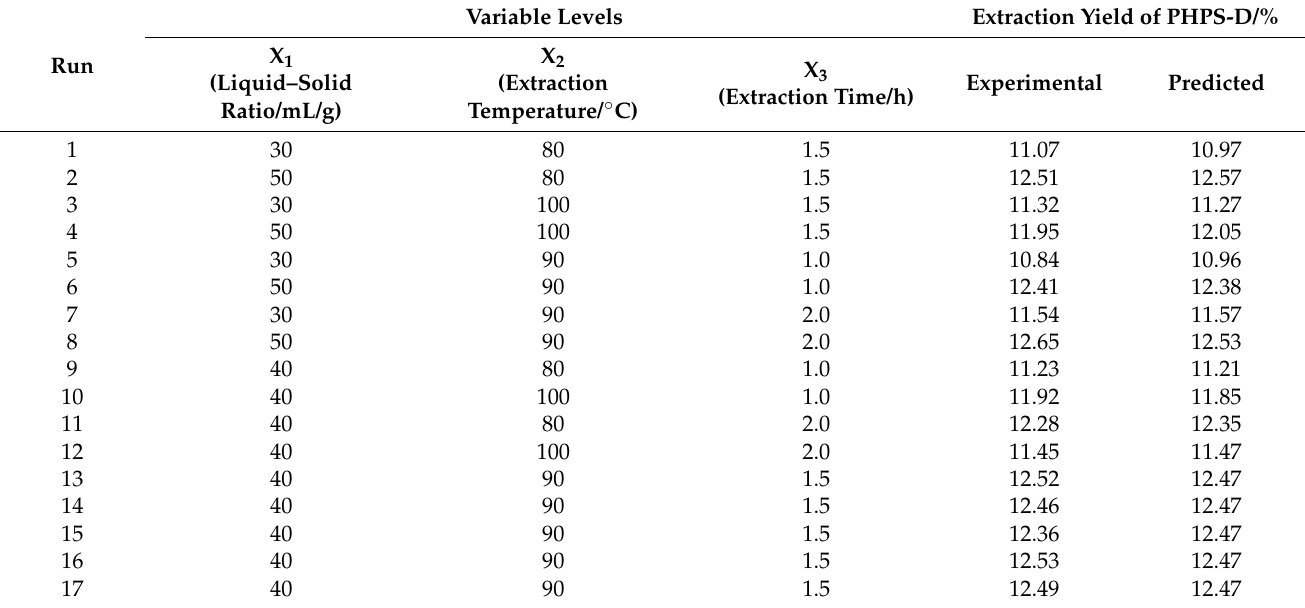
Table 1. Design and results of the response surface